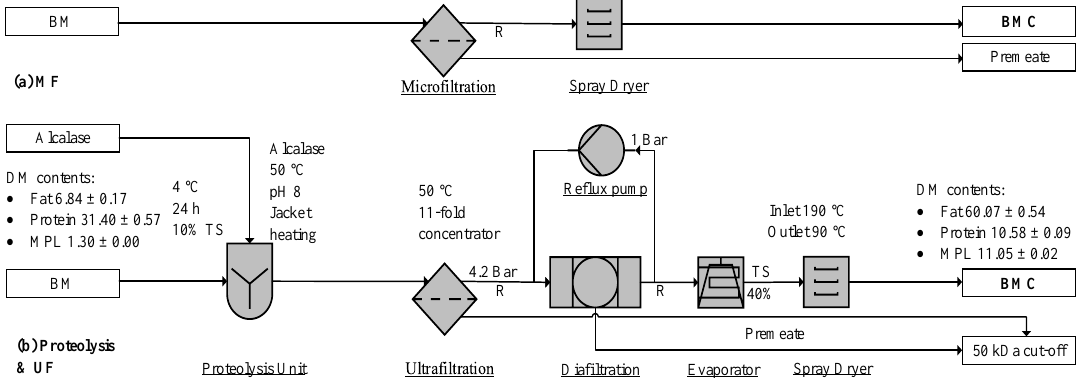
Figure 4. Filtration to enrich milk phospholipids (MPLs): ( a ) microfiltration (MF) [98] and ( b ) ultrafiltration (UF) [96]. BM, buttermilk; BMC, BM concentrate; TS, total solid; R, retentate.